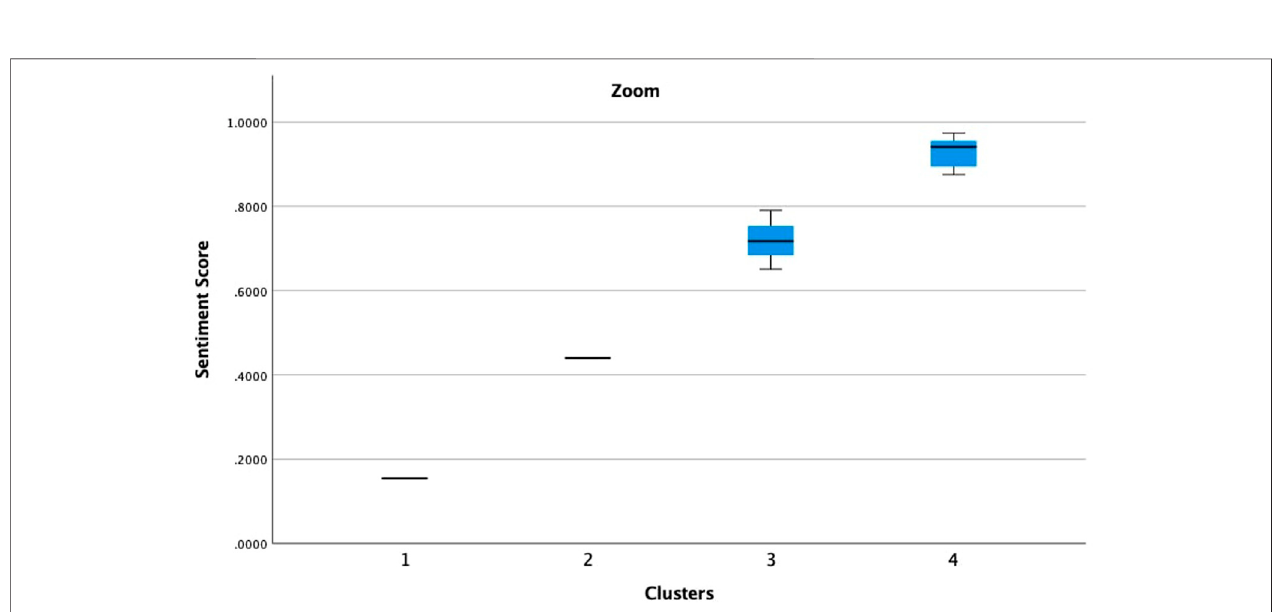
FIGURE5| ThesentimentscoresforthewrittenresponsestotheZoomapplicationrangedfrom0.1548to0.9741,withmeanof0.783±SD:0.244,andmedian= 0.891. The sentiment scores are not signi fi cantly different between females and males, and are not correlated with age.